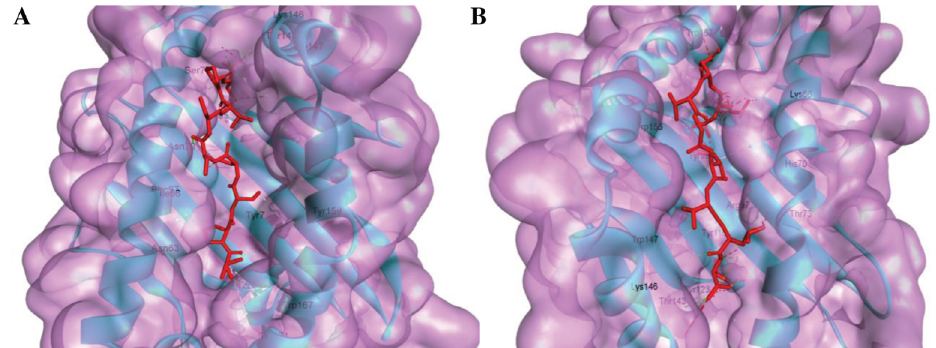
Figure 3: Docking predicts the interaction of predicted epitopes to MHC class I molecule, HLA-A*02:03 and HLA-B*35:01. Binding of “ ALQTGITLV ” to the interacting grooves of the generated structure of HLA-A*02:03 (binding energy: − 8.4 Kcal/mol). Binding of “ VPSSSTPL ” to the binding grooves of the retrieved structure of HLA-B*35:01. (Binding energy: − 8.5 Kcal/mol) The blue colored portion and green portion in both figure (A and B) represent HLA-A*02:03 molecule, ALQTGITLVL epitope and HLA-B*35:01 molecules and VPSSSTPL epitope, respectively.